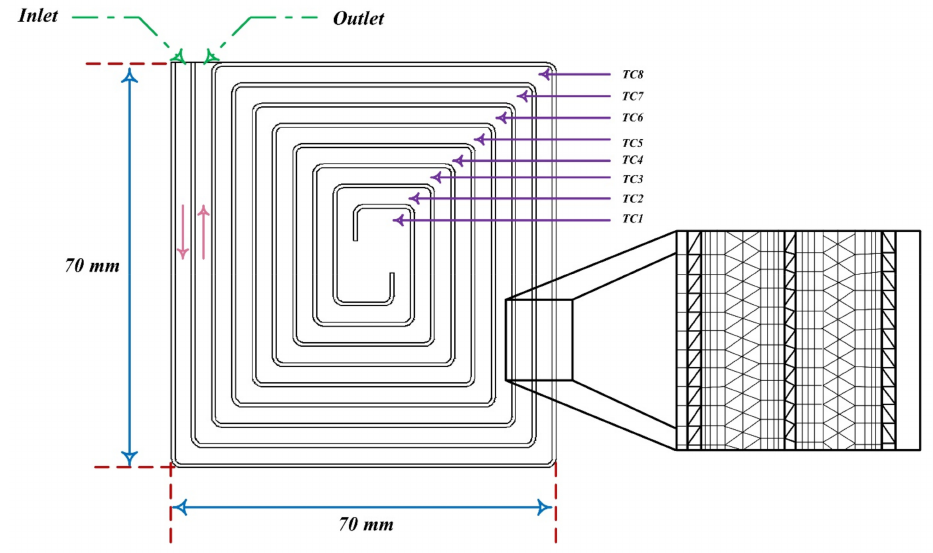
Figure 26. Geometry and grid structure of the modeled Swiss-roll combustor